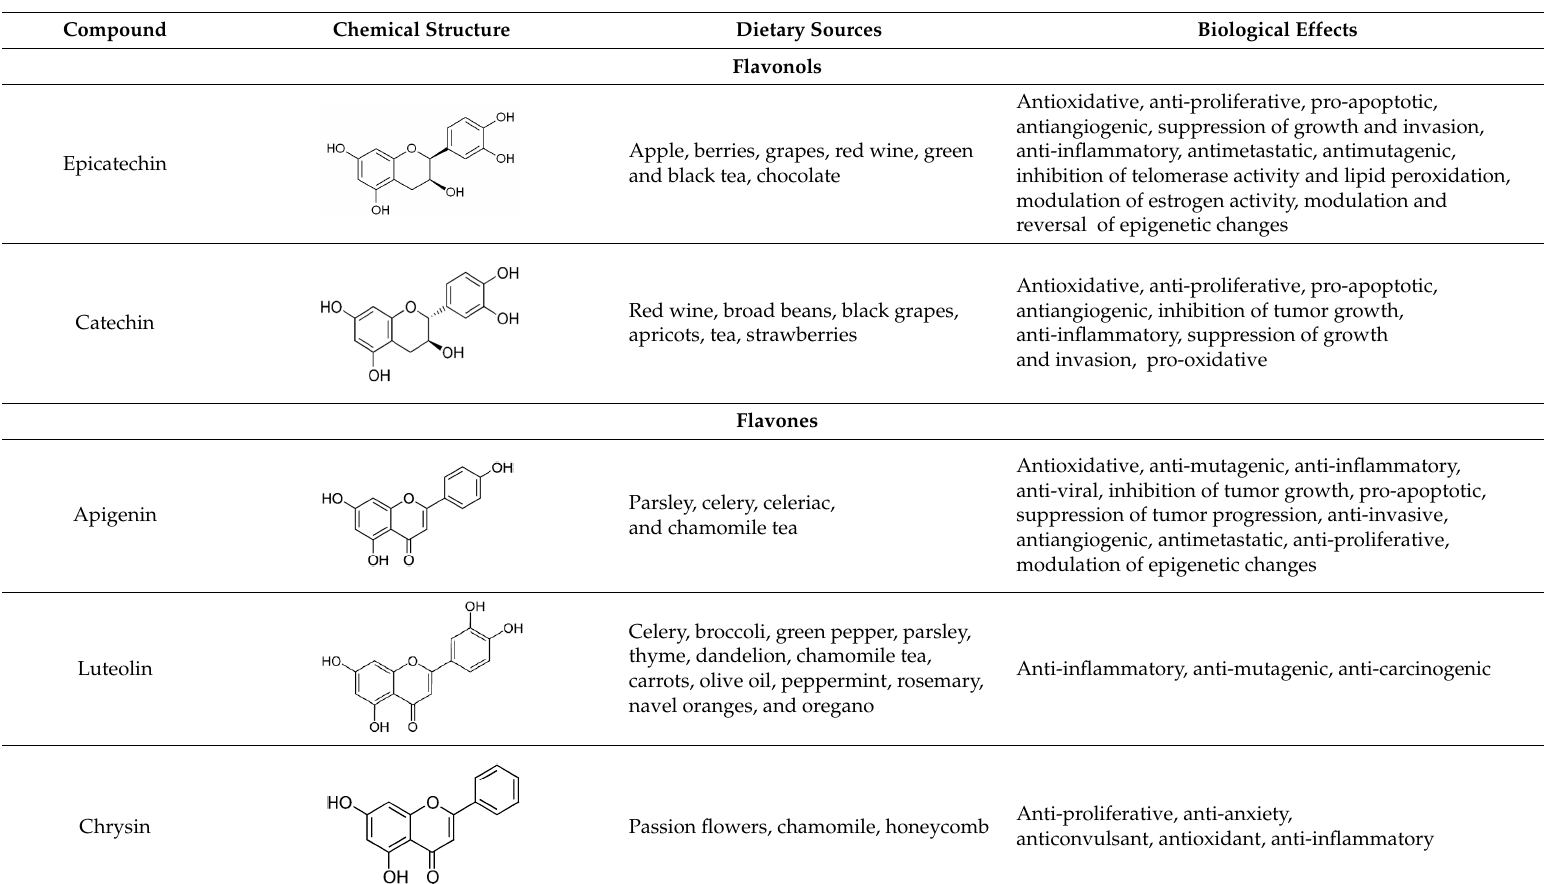
Table 1. Sources of polyphenols, chemical structure and their biological activities [13–15,35,36,43–48].